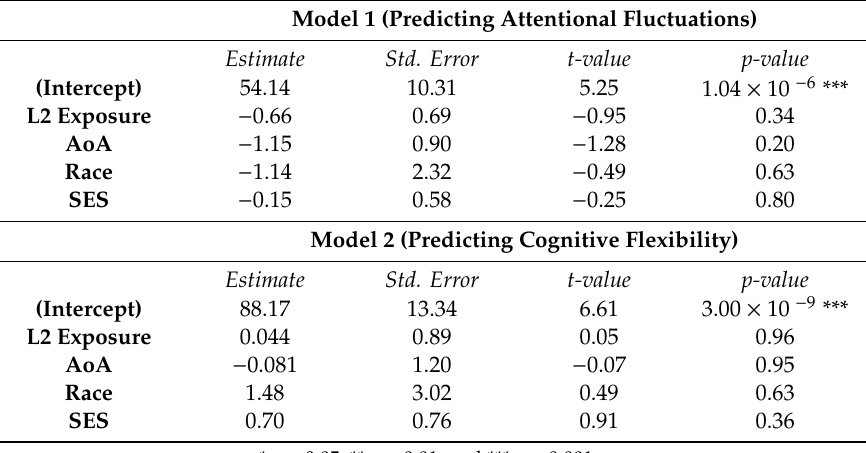
Table 2. Regression models for attentional fluctuations (Model 1) and cognitive flexibility (Model 2).